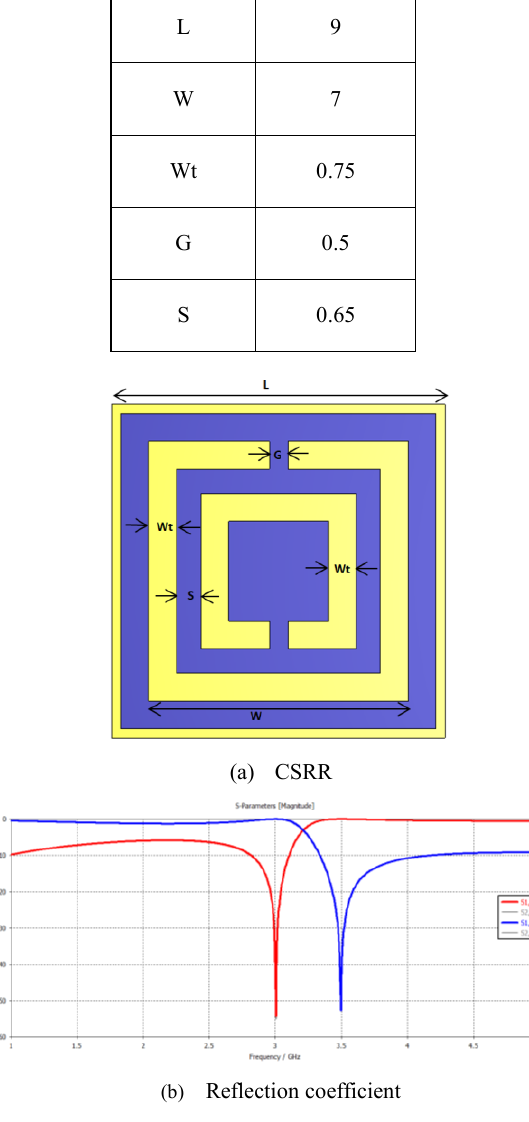
Fig. 1. (a) Representation and parameters of a square CSRR cell unit. (b) S Parameters in dB.